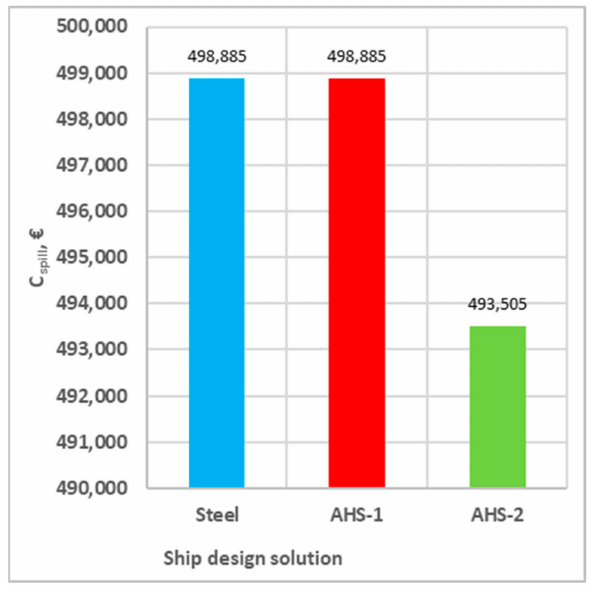
Figure 7. Accidental spill cost.